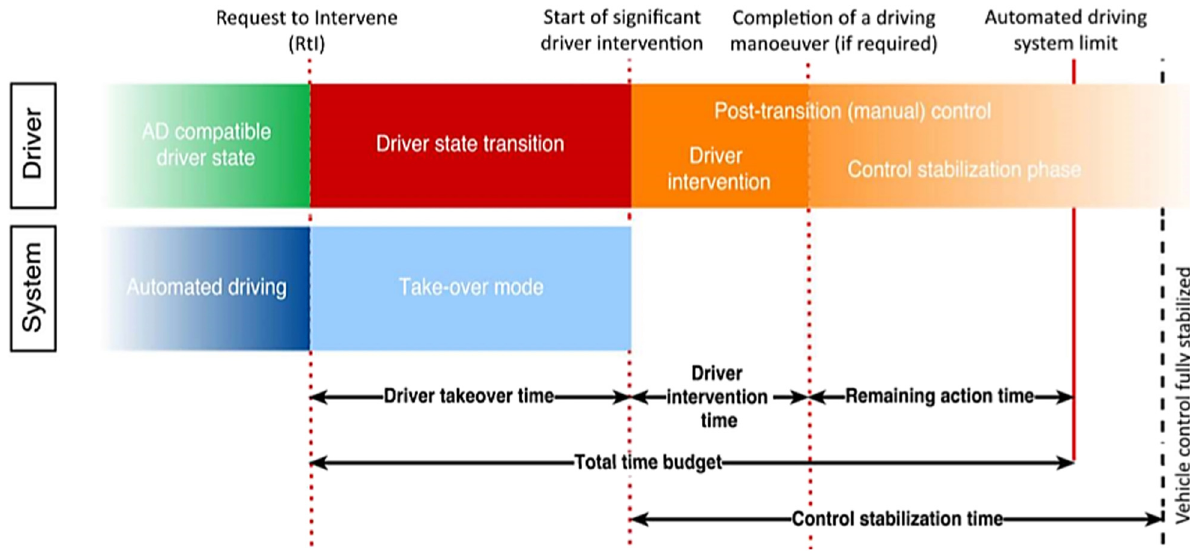
Figure 2: System - initiated vehicle control transition [ 8 ]